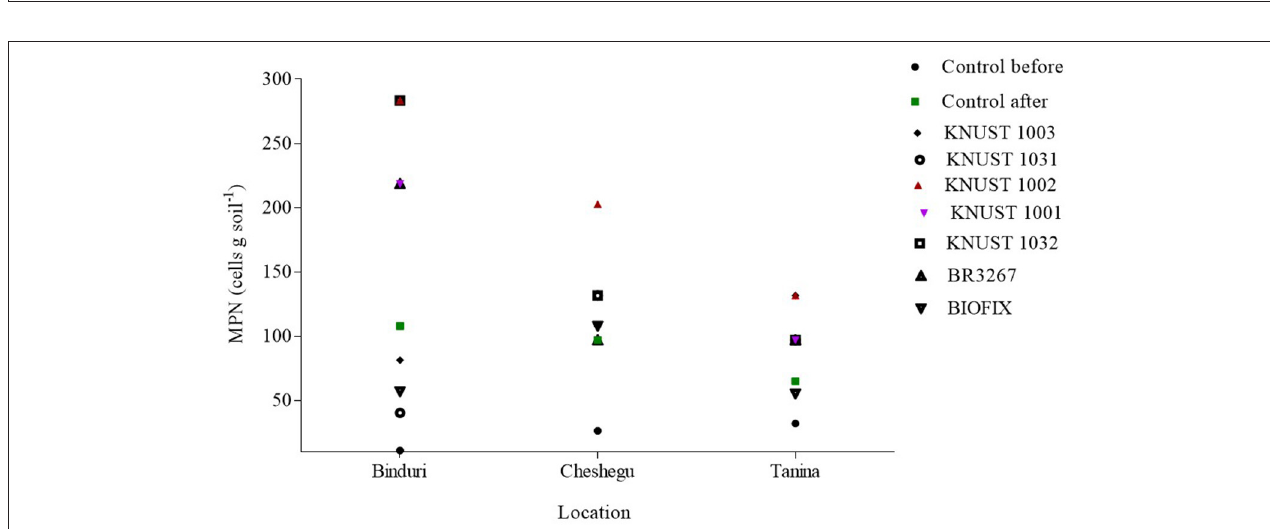
FIGURE 2 | Rhizobia population after one cropping season of introduction. The legends describe the rhizobia population in the control plots before and after the experiment as well as the plots that received the various strains.